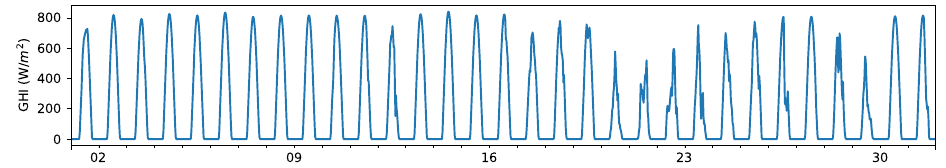
Figure 5. Observed GHI for December